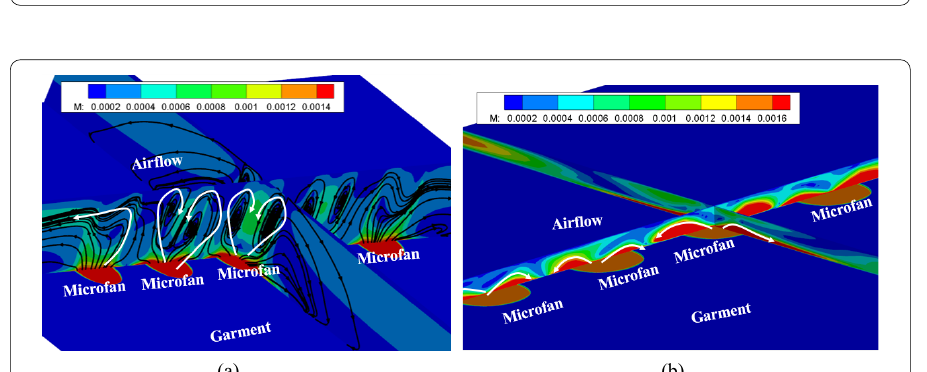
Fig. 10 Parallel flats model